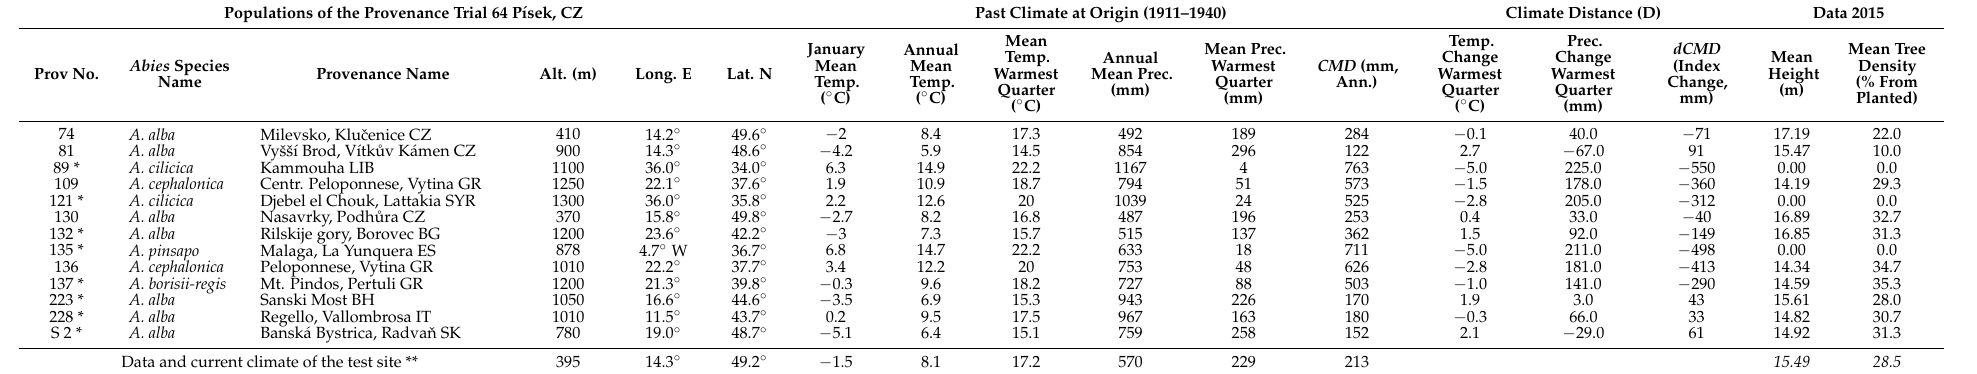
Table 3. Basic data of the provenance trial 64, P í sek: species and populations represented and basic data used for analysis (sequence and geographic data of provenances are identical to the source publication (Adapted partly from [20]). Climate distances refer to the trial location.